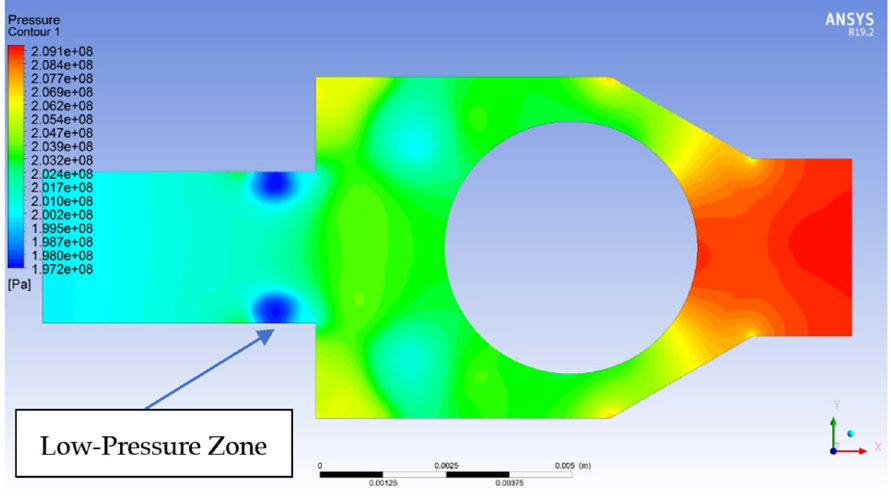
Figure 9. Pressure CFD: Conical Seat Valve − x = 1.005 [mm], p dn = 2000 [bar] and p up = 2100 [bar].